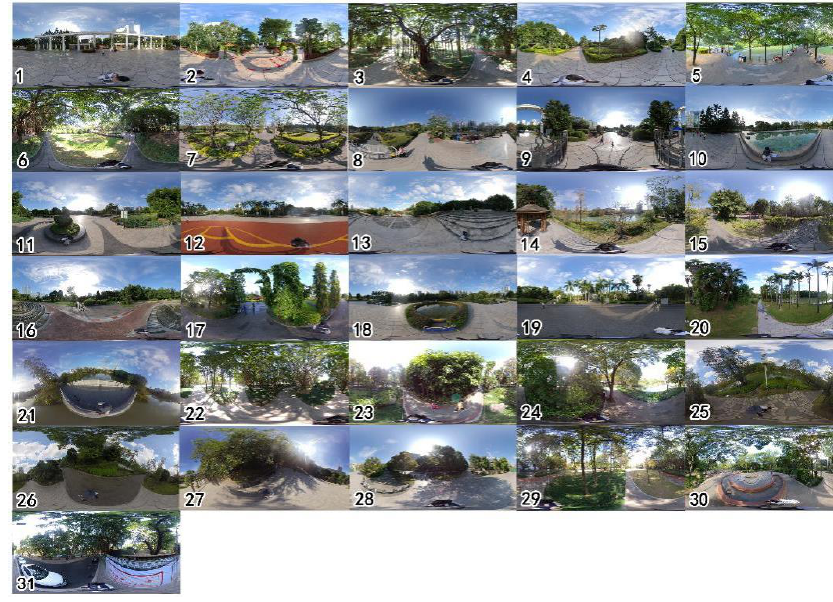
Figure 2. Panoramic overview of 31 monitoring point.